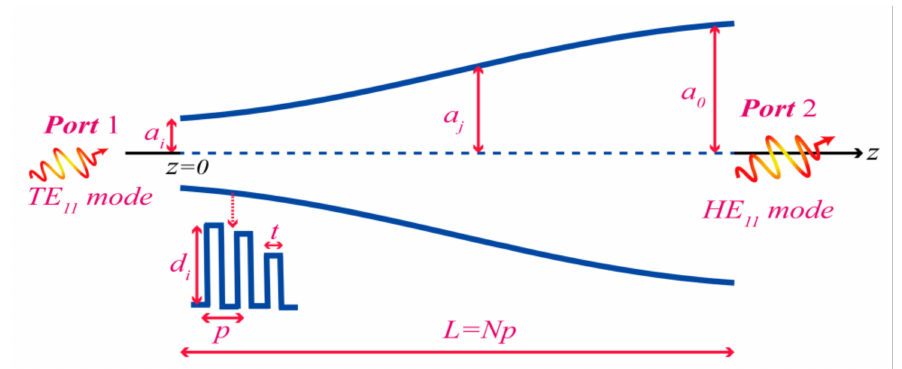
Figure 2. Schematic diagram of a TE 11 -HE 11 mode corrugated